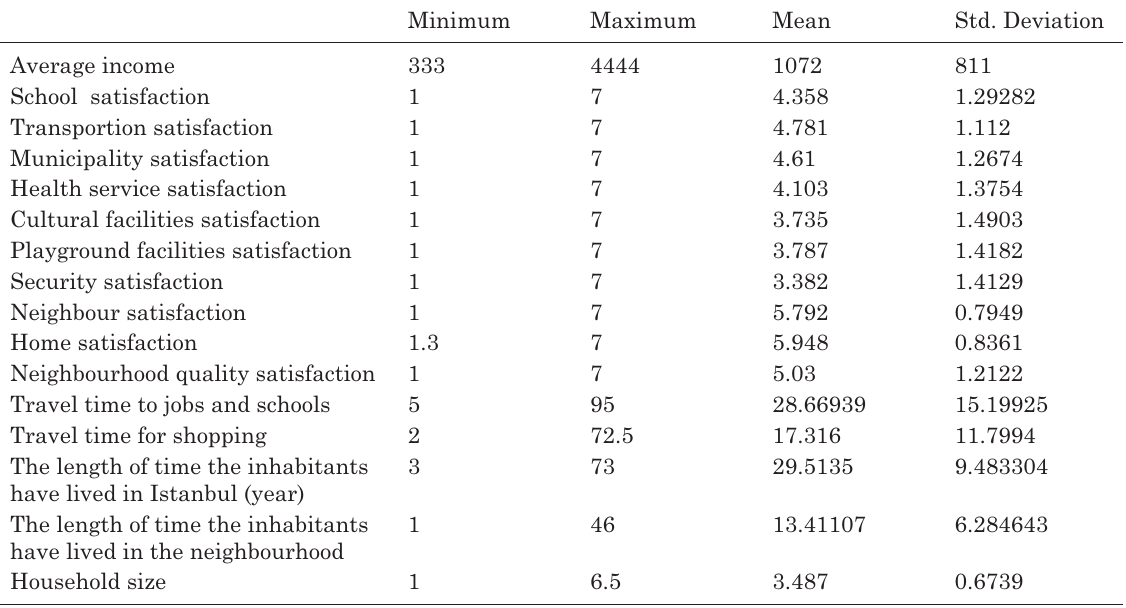
Table 2. Descriptive statistics of socio-economic and neighbourhood quality characteristics of neighbourhoods N: